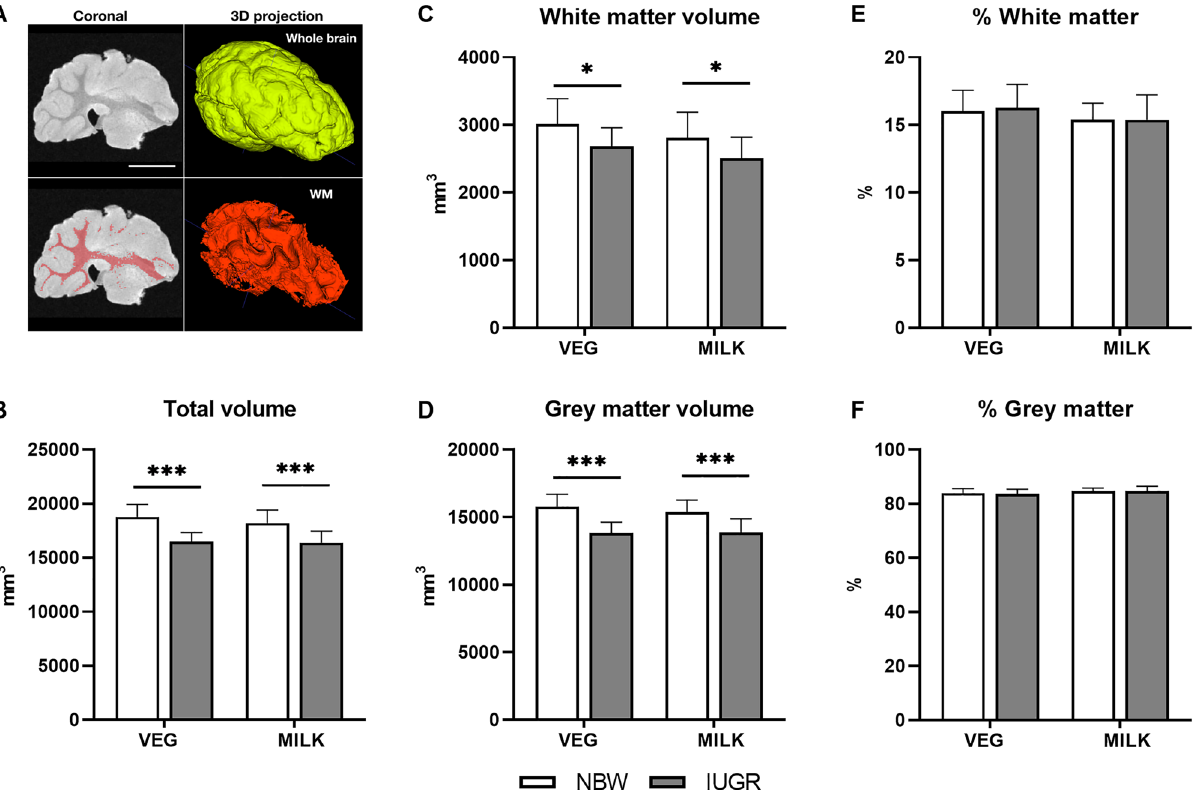
Figure 4. Magnetic resonance imaging on day 21–22. ( A ) A representative coronal and 3D reconstructed image showing the mapping of white matter (red), ( B ) absolute total volume, ( C ) absolute white matter volume, ( D ) absolute grey matter volume, ( E ) percentage white matter and ( F ) percentage grey matter of the right hemisphere of brains (n = 7). Scale bar = 1 cm. Data are shown as mean ± SD. All data were analysed using a linear mixed model. Statistically significant differences between groups are shown as *p < 0.05 and ***p < 0.001. Figures were created with ITK-SNAP (version 3.8.0, www. itksn ap. org) ( A ) and GraphPad Prism (version